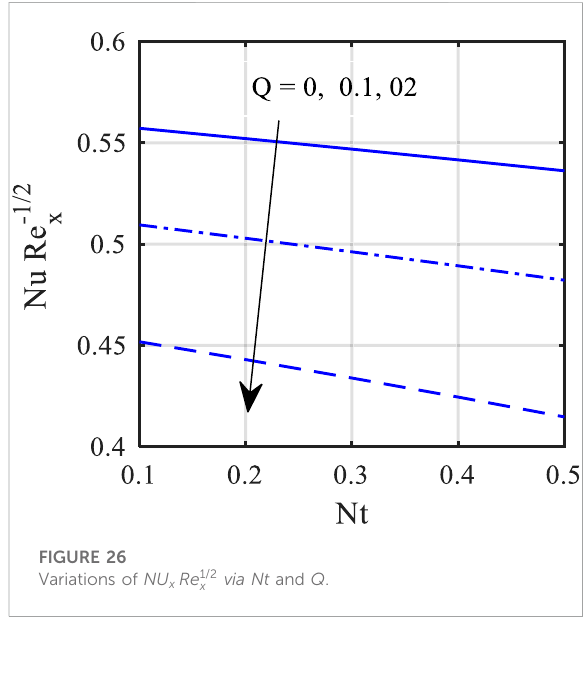
FIGURE 26 Variations of NU x Re 1/2 x via Nt and Q .